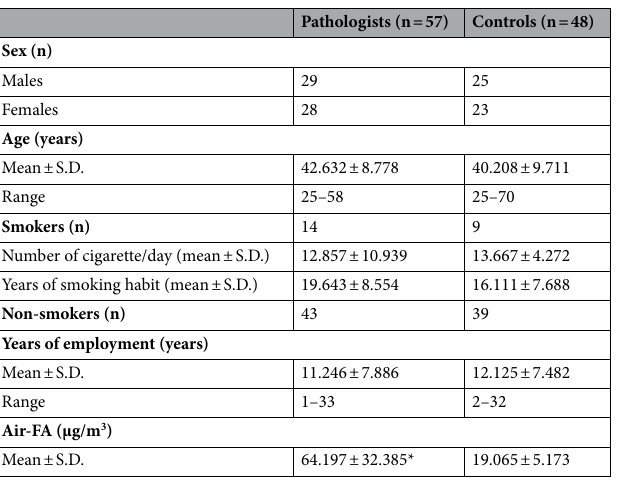
Table 1. Demographic characteristics and air-FA exposure level of subjects belonging to the studied groups. n number of analysed subjects, S.D. standard deviation. * P < 0.001, Kruskal–Wallis, Significantly higher with respect to Controls.